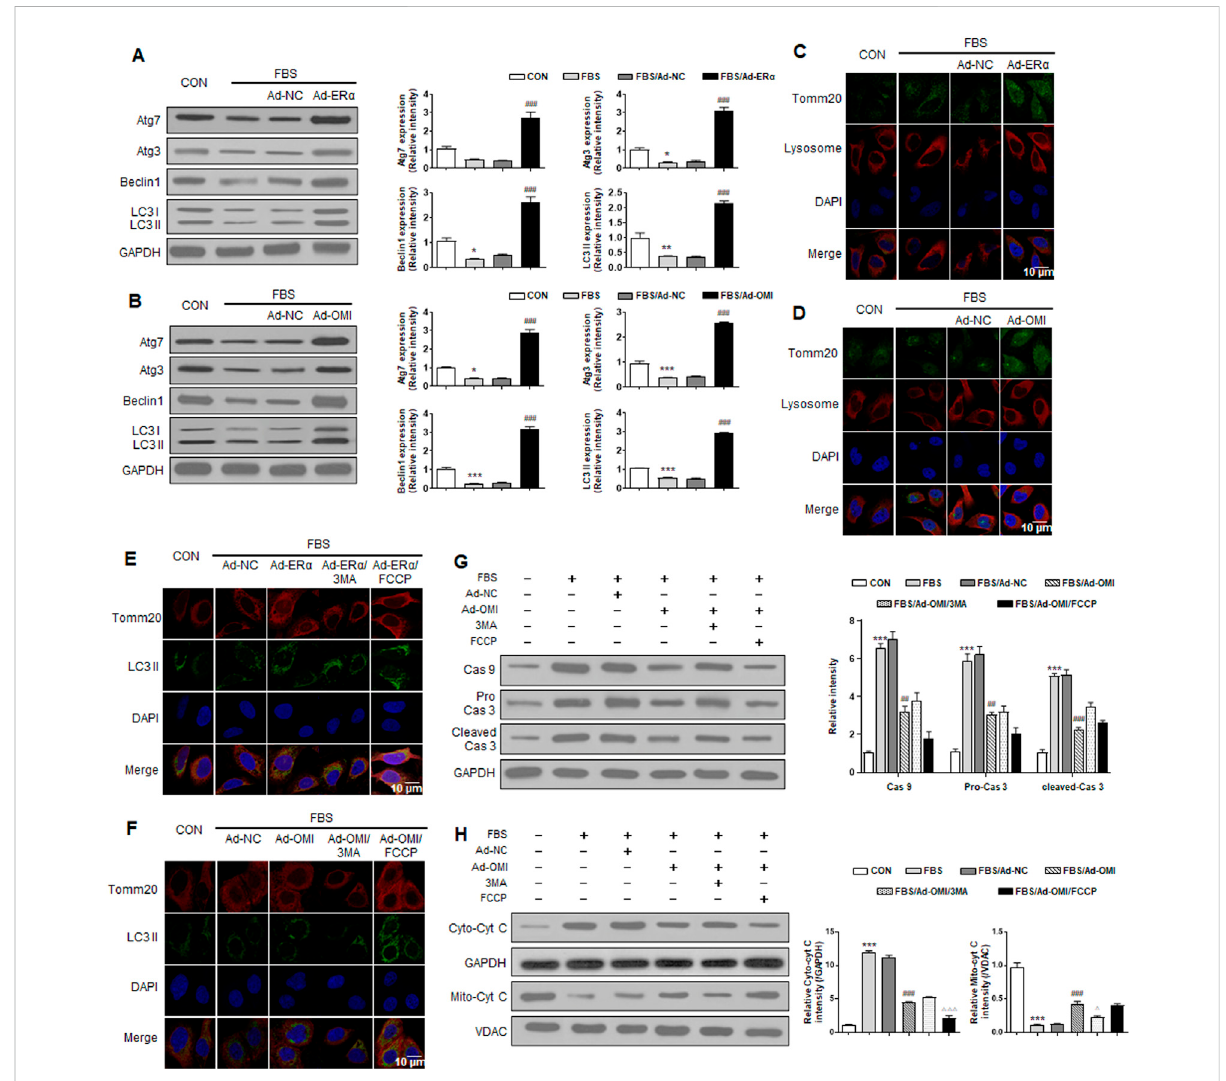
FIGURE 5 ER α -NRF1-OMI regulates macroautophagy and mitophagy fl ux. (A – C) Western blot analysis of Atg7, Atg3, beclin1, LC3 I and LC3 II (A) , the co- staining of TOMM20, lysosome and DAPI (B) and the co-staining of TOMM20, LC3 II and DAPI (C) in A7r5 cells treated with FBS, transfected with adenoviruses expressing ER α or noncoding control. (D-H) Western blot analysis of Atg7, Atg3, beclin1, LC3 I and LC3 II (D) , the co-staining of TOMM20, lysosome and DAPI (E) , the co-staining of TOMM20, LC3 II and DAPI (F) , the expression level of caspase9, caspase3 and cleaved caspase3 (G) and cytosolic cyt-c and mitochondrial cyt-c (H) in A7r5 cells treated with FBS, transfected with adenoviruses expressing OMI or noncoding control. 3MA and FCCP were used as mitophagy inhibitor and activator respectively. * p < 0.05, ** p < 0.01 and *** p < 0.001 vs.